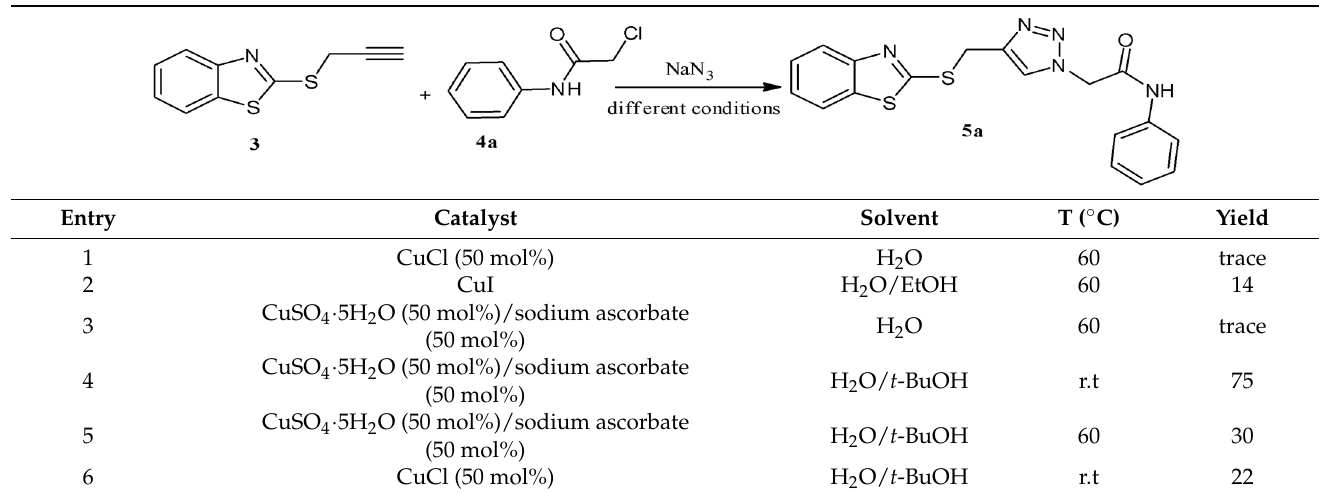
Table 1. Optimization of catalyst, solvent, and temperature for the synthesis of 5a a .